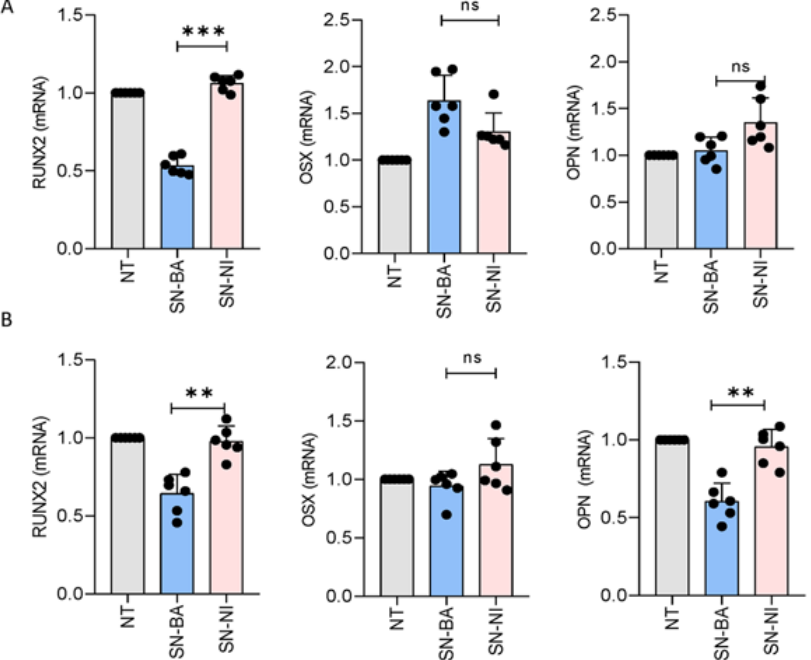
Figure 6. Culture supernatants from B. abortus -infected adipocytes inhibit Runt-related transcription factor 2 (Runx2) transcription by osteoblasts. Effects of culture supernatants from B. abortus -infected adipocytes (SN-BA) on osteoblast differentiation transcription factors. Runx2, Osterix (Osx), and osteopontin (OPN) transcription were determined by RT-qPCR at day 1 ( A ) and at day 14 ( B ) post-stimulation. Cells stimulated with culture supernatants from non-infected adipocytes (SN-NI) were used as control. NT: non-treated, ** p < 0.001, *** p < 0.0001 vs. cells treated with culture supernatants from non-infected cells (SN-NI). ns: non-significant.